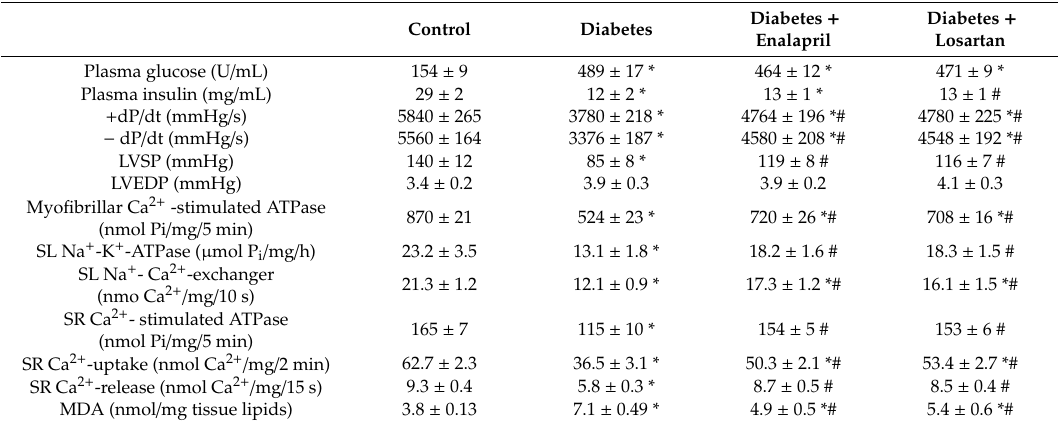
Table 4. Glucose / insulin levels, hemodynamic parameters and subcellular activities of control, diabetic and enalapril- or losartan-treated diabetic